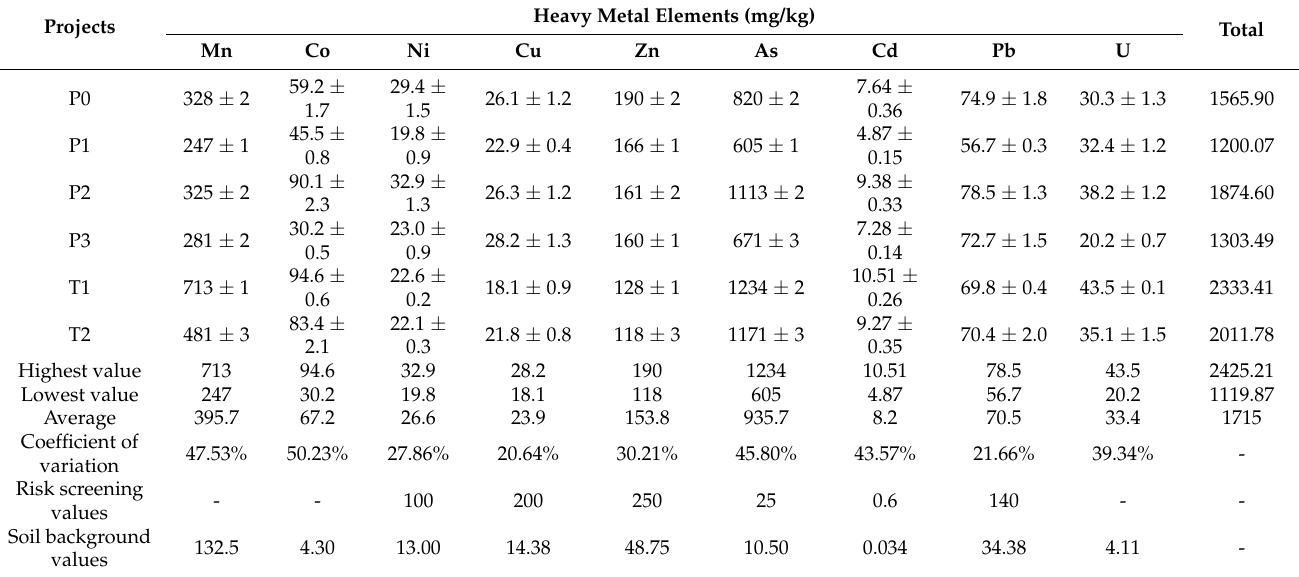
Table 5. Content of uranium and heavy metals in the soil of a uranium mining area in northern Guangdong